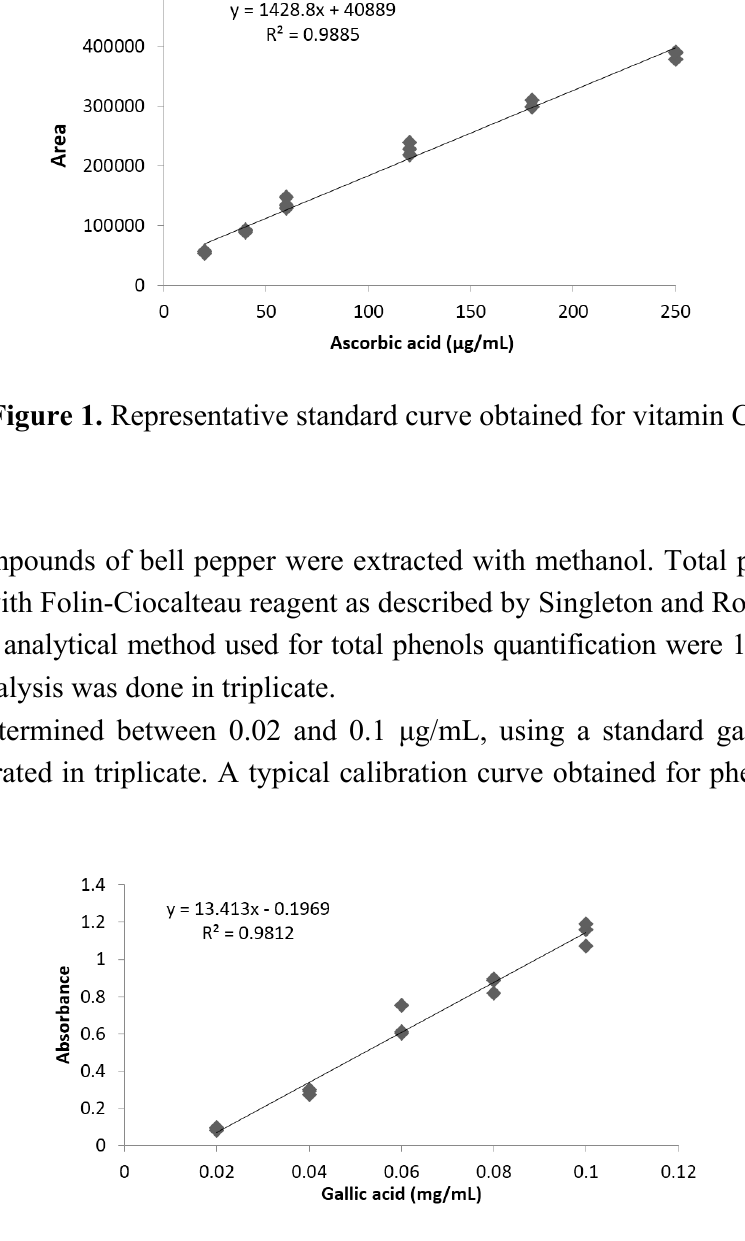
Figure 2. Representative standard curve obtained for total